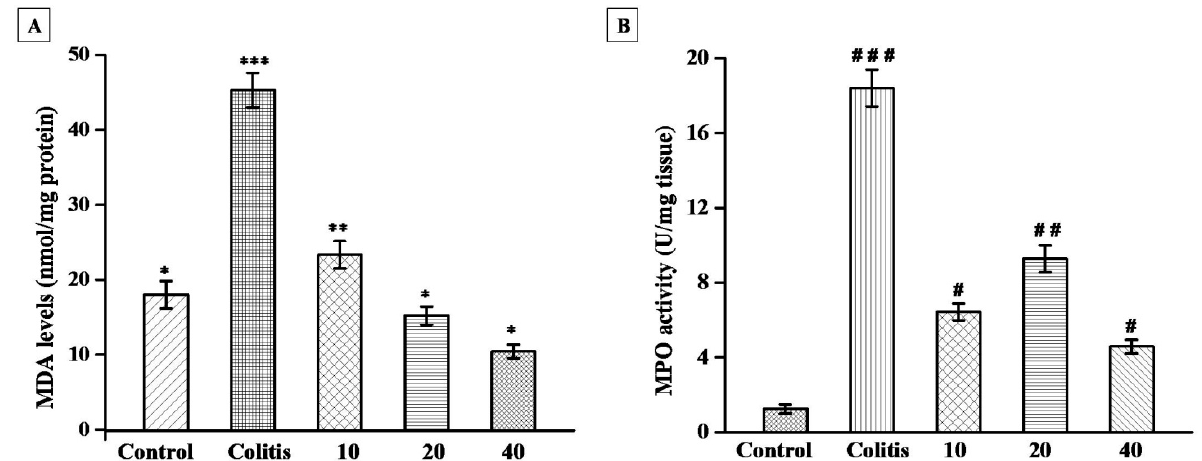
Figure 6. Effect of Sal B on LPO and MPO activity in mice’s colon tissue with AA-induced experimental colitis ( n = 6). ( A ) Effect of Sal B on lipid peroxidation * p < 0.05, ** p < 0.01, *** p < 0.001 as compared with control, ( B ) Effect of Sal B on MPO activity. The data are represented as mean ± SD and evaluated using one-way ANOVA, followed by Tukey’s multiple range tests for post hoc analysis. # p < 0.05, ## p < 0.01, ### p < 0.001 as compared with control.